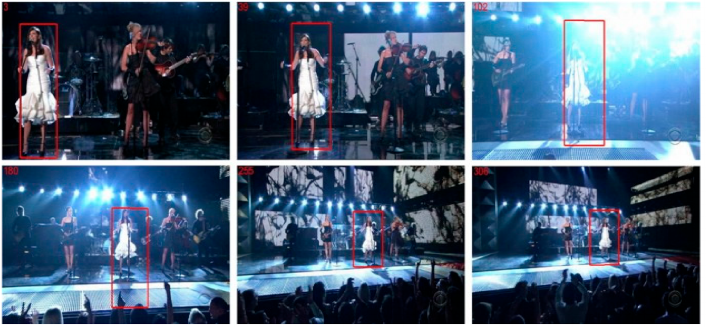
Figure 12. Tracking of a human person in a complex environment (Data Set: Singer).